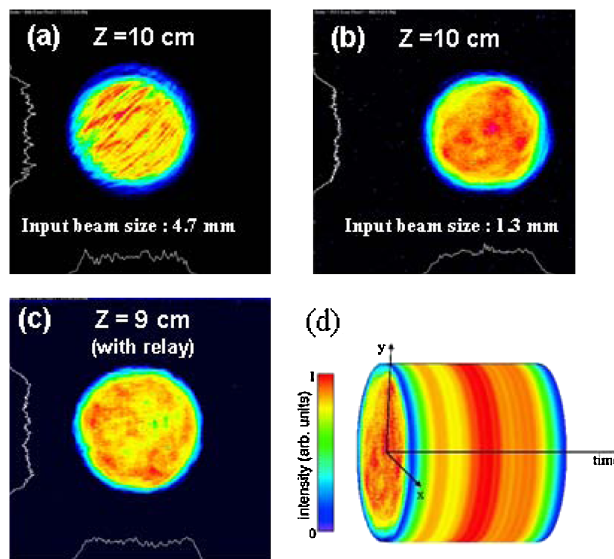
7. (Color) Spatial beam profiles at 10 cm away from the (cid:5) shaper with beam expander positioned: (a) before the pulse stacker; (b) after the pulse stacker; (c) same as (b) but image relayed to (cid:1) 9 m ; (d) reconstructed beam envelope of the spa- tiotemporal shaped beer-can light pulse